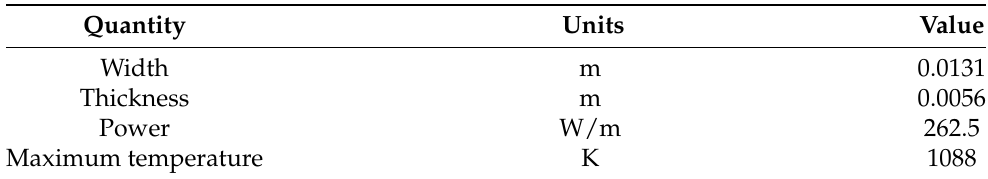
Table 7. The generic characteristics of a series-connected, mineral-insulated, flat cross-section heat trace cable [74,75].